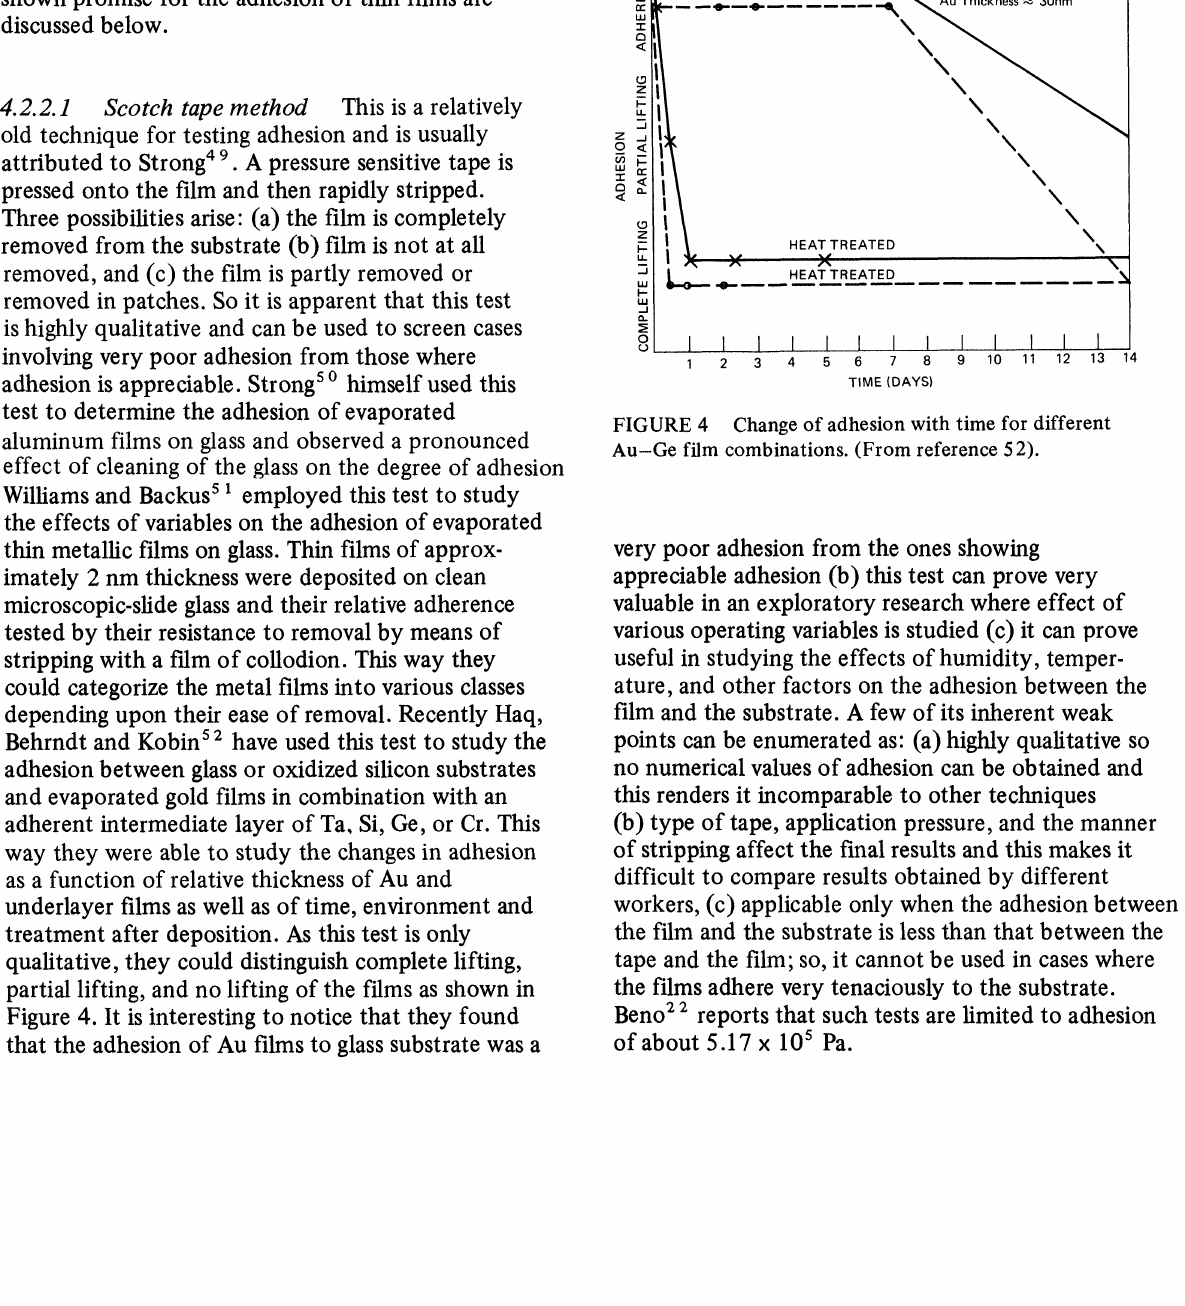
FIGURE 4 Change of adhesion with time for different Au-Ge film combinations. (From reference